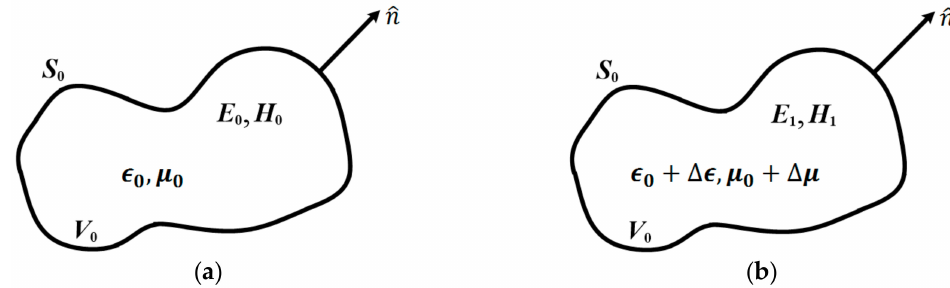
Figure 1. Diagram of the cavity perturbation: ( a ) empty cavity; ( b ) perturbed